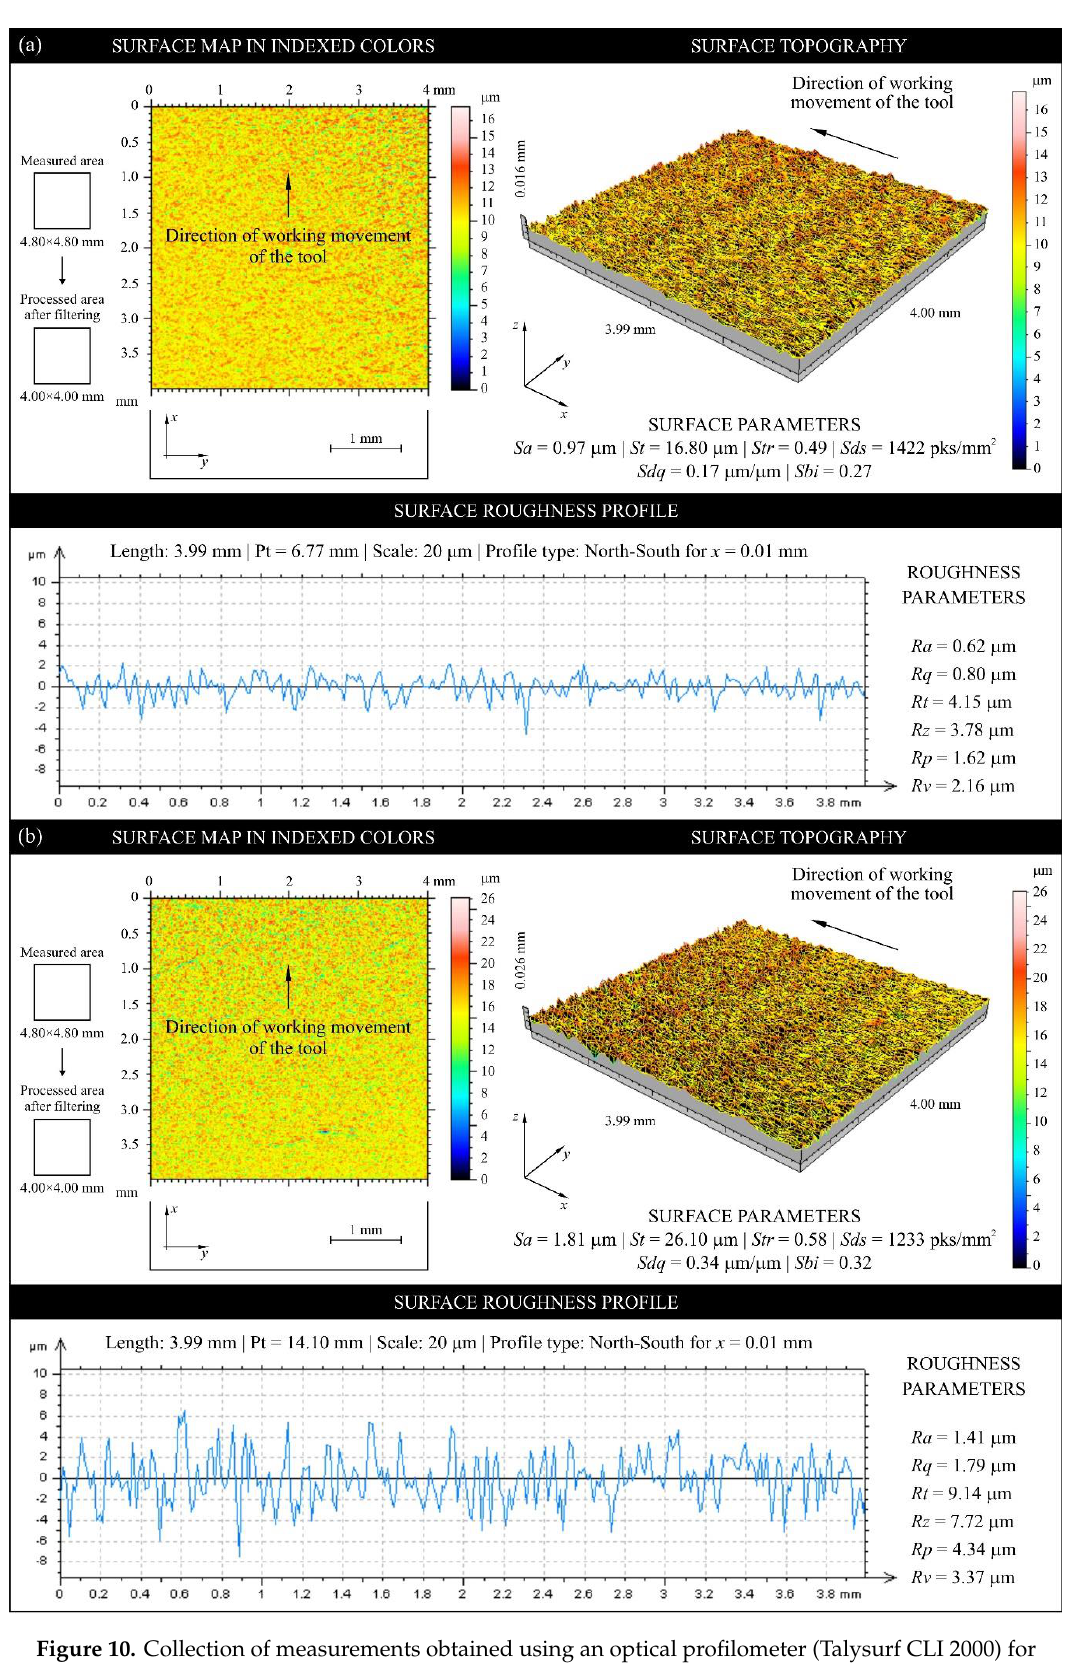
Figure 10. Collection of measurements obtained using an optical profilometer (Talysurf CLI 2000) for the rake face of CrCN/CrN-coated industrial planer knife No. 35 (Set 1, Head L1) ( a ) before processing (reference) and ( b ) after processing.